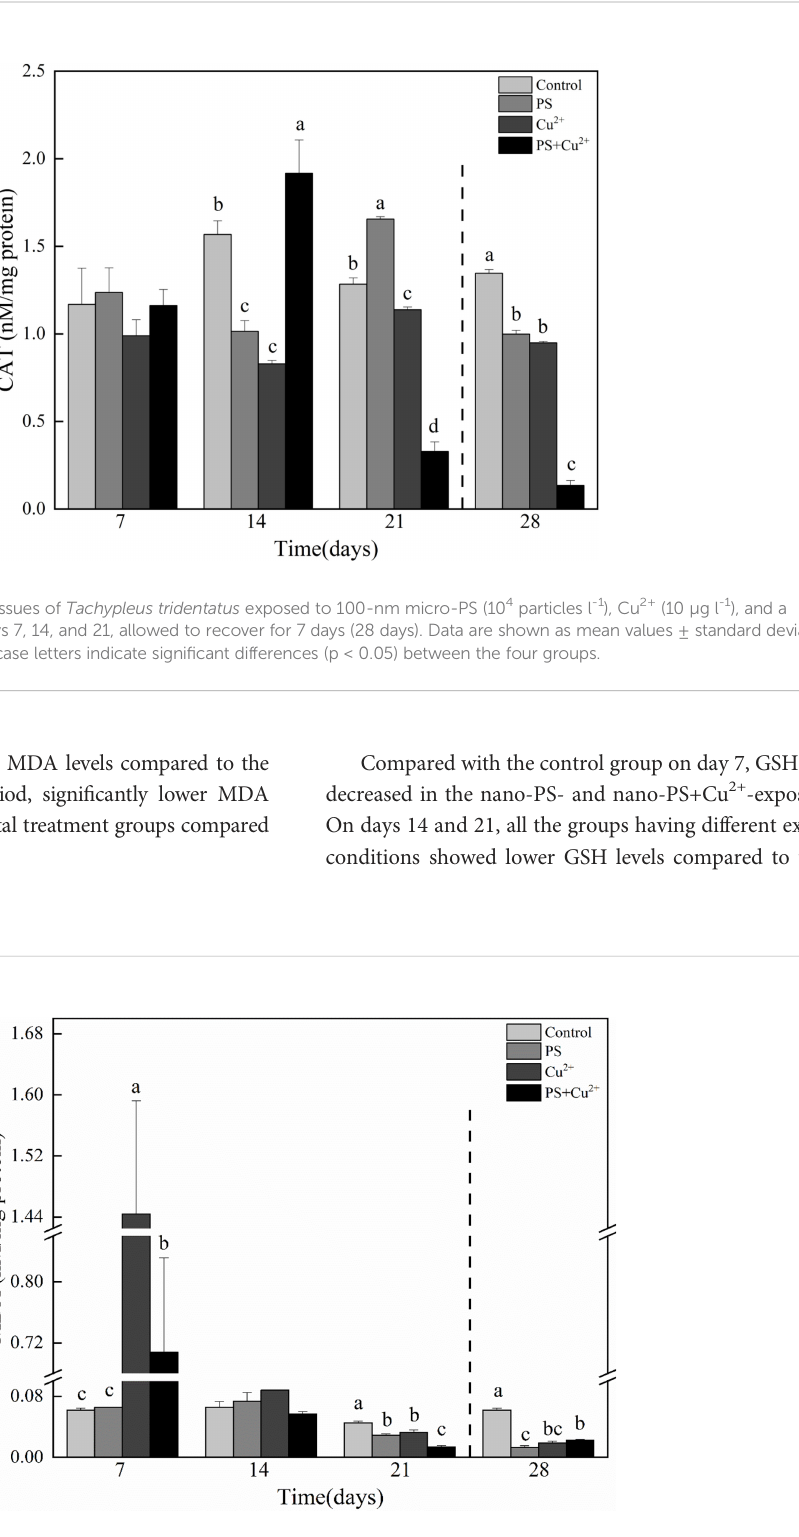
FIGURE 3 Malondialdehyde (MDA) activities in whole tissues of Tachypleus tridentatus exposed to 100-nm micro-PS (10 4 particles l -1 ), Cu 2+ (10 µg l -1 ), and a combination of PS and Cu 2+ at days 7, 14, and 21, allowed to recover for 7 days (28 days). Data are presented as mean values ± standard deviations. The superscripts of different lowercase letters indicate signi fi cant differences (p < 0.05) between the four